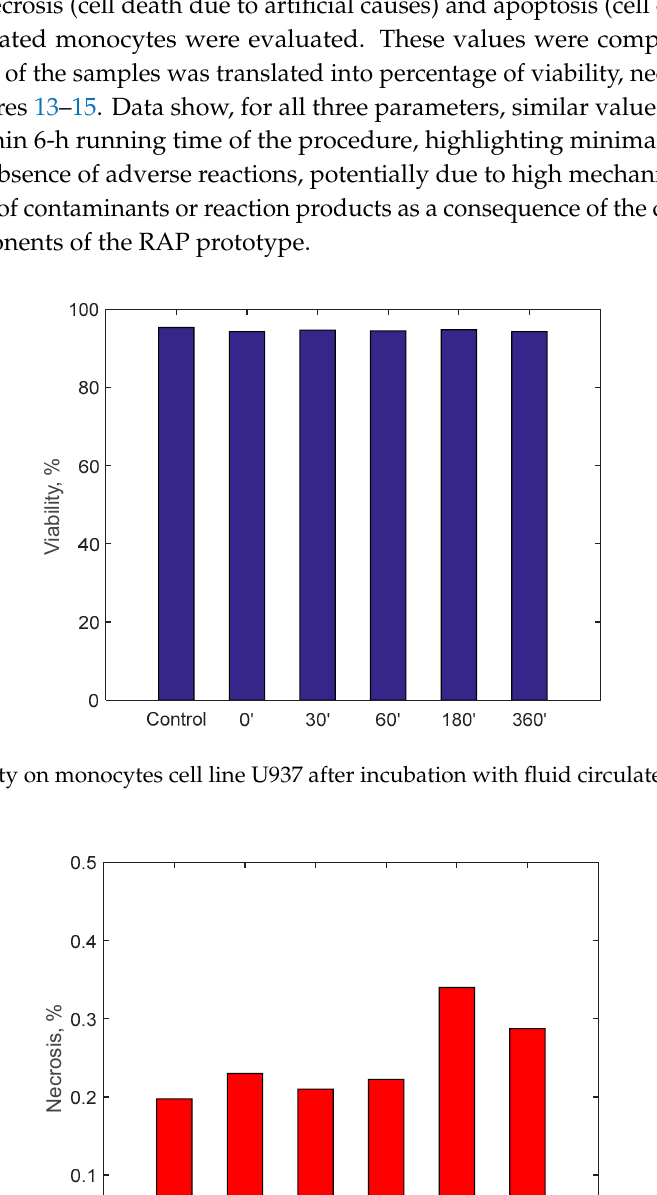
Figure 12. Ultrafiltrate volumes set in the device (black), estimated by RAP (red) and effectively measured by external scale (green).